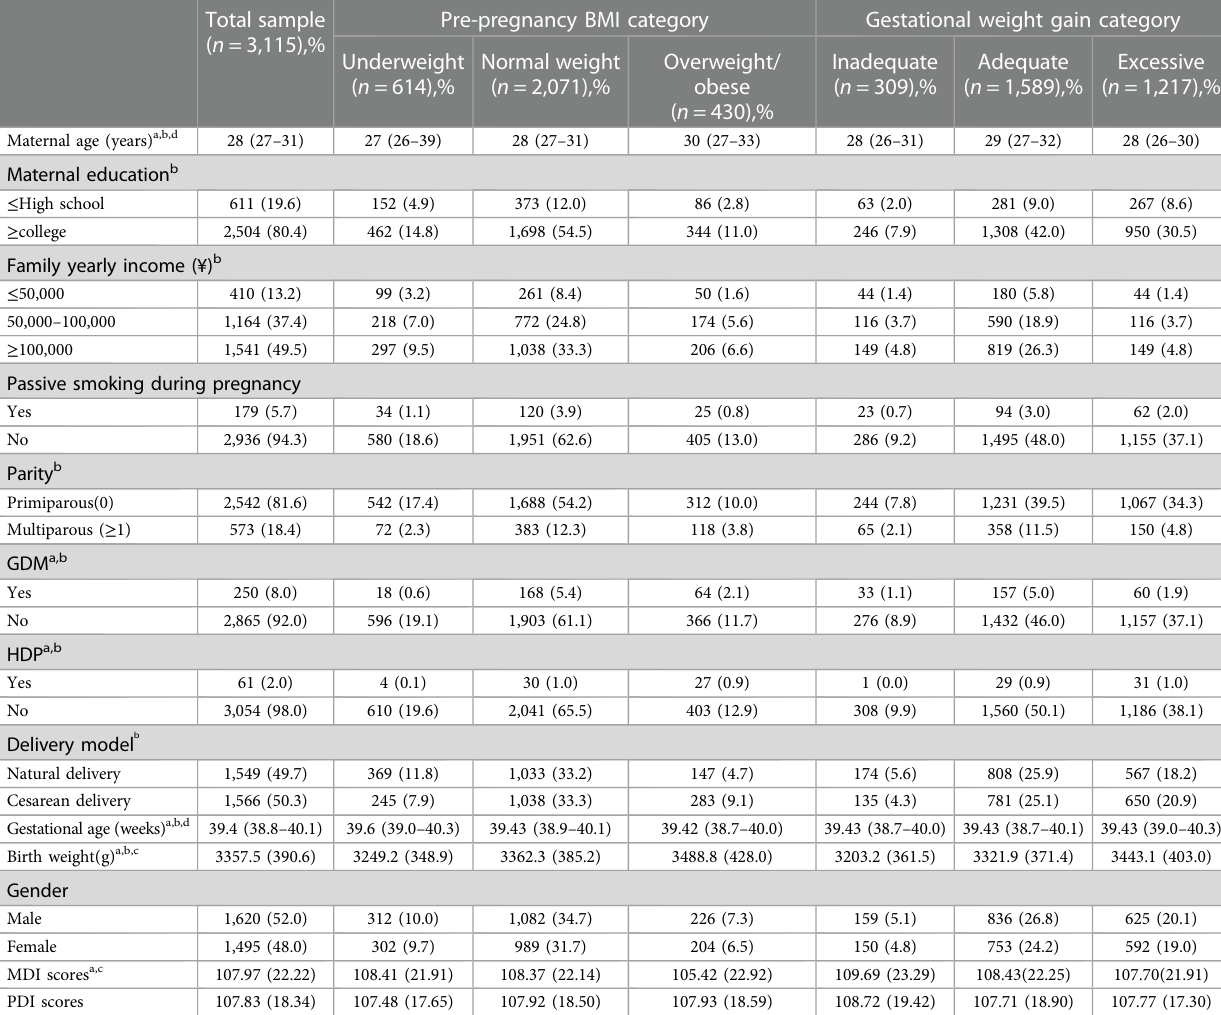
TABLE 1 Features of mothers and babies based on pre-pregnancy body mass index (BMI) and gestational weight gain (GWG) ( n =3,115). Total sample ( n =